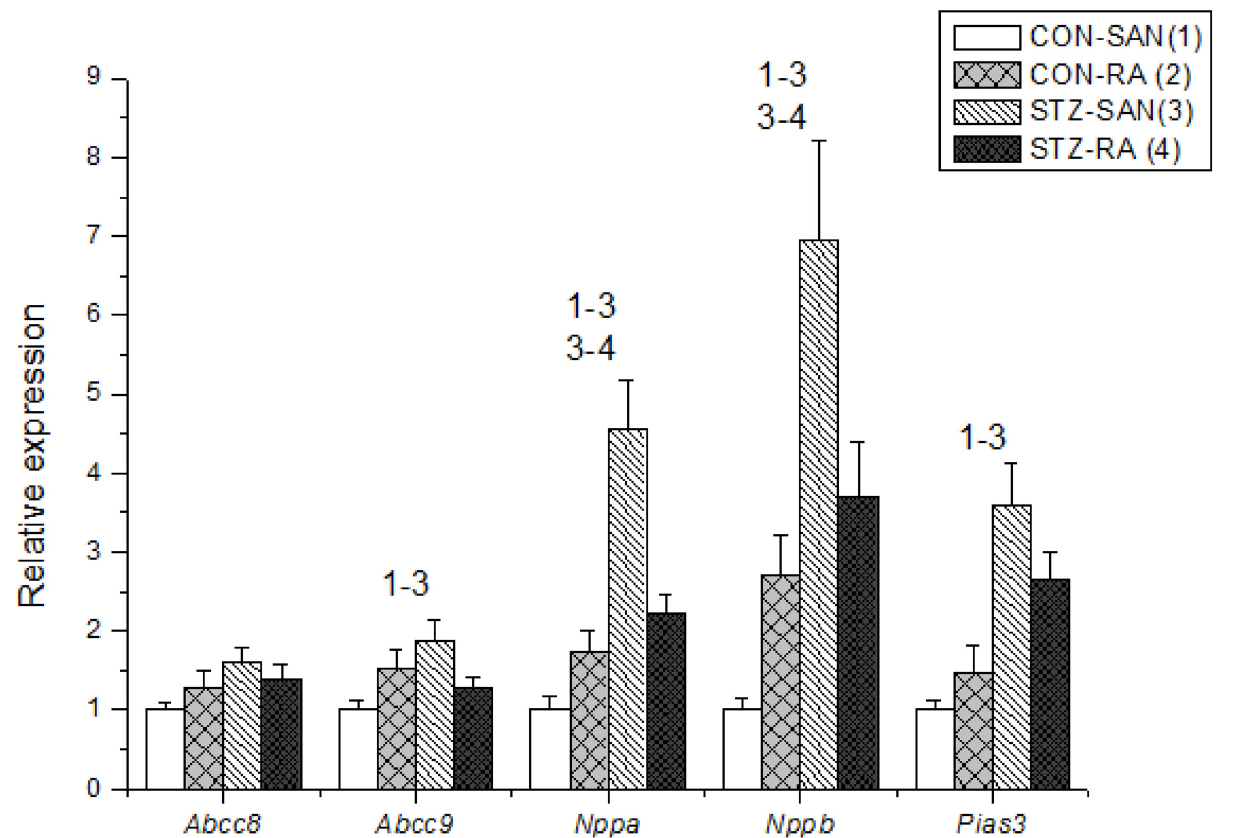
Fig 10. Expression of genes encoding miscellaneous cardiac proteins. Data are mean ± SEM, n = 8 – 10 samples from STZ and control rat each containing SANs from 2 hearts.